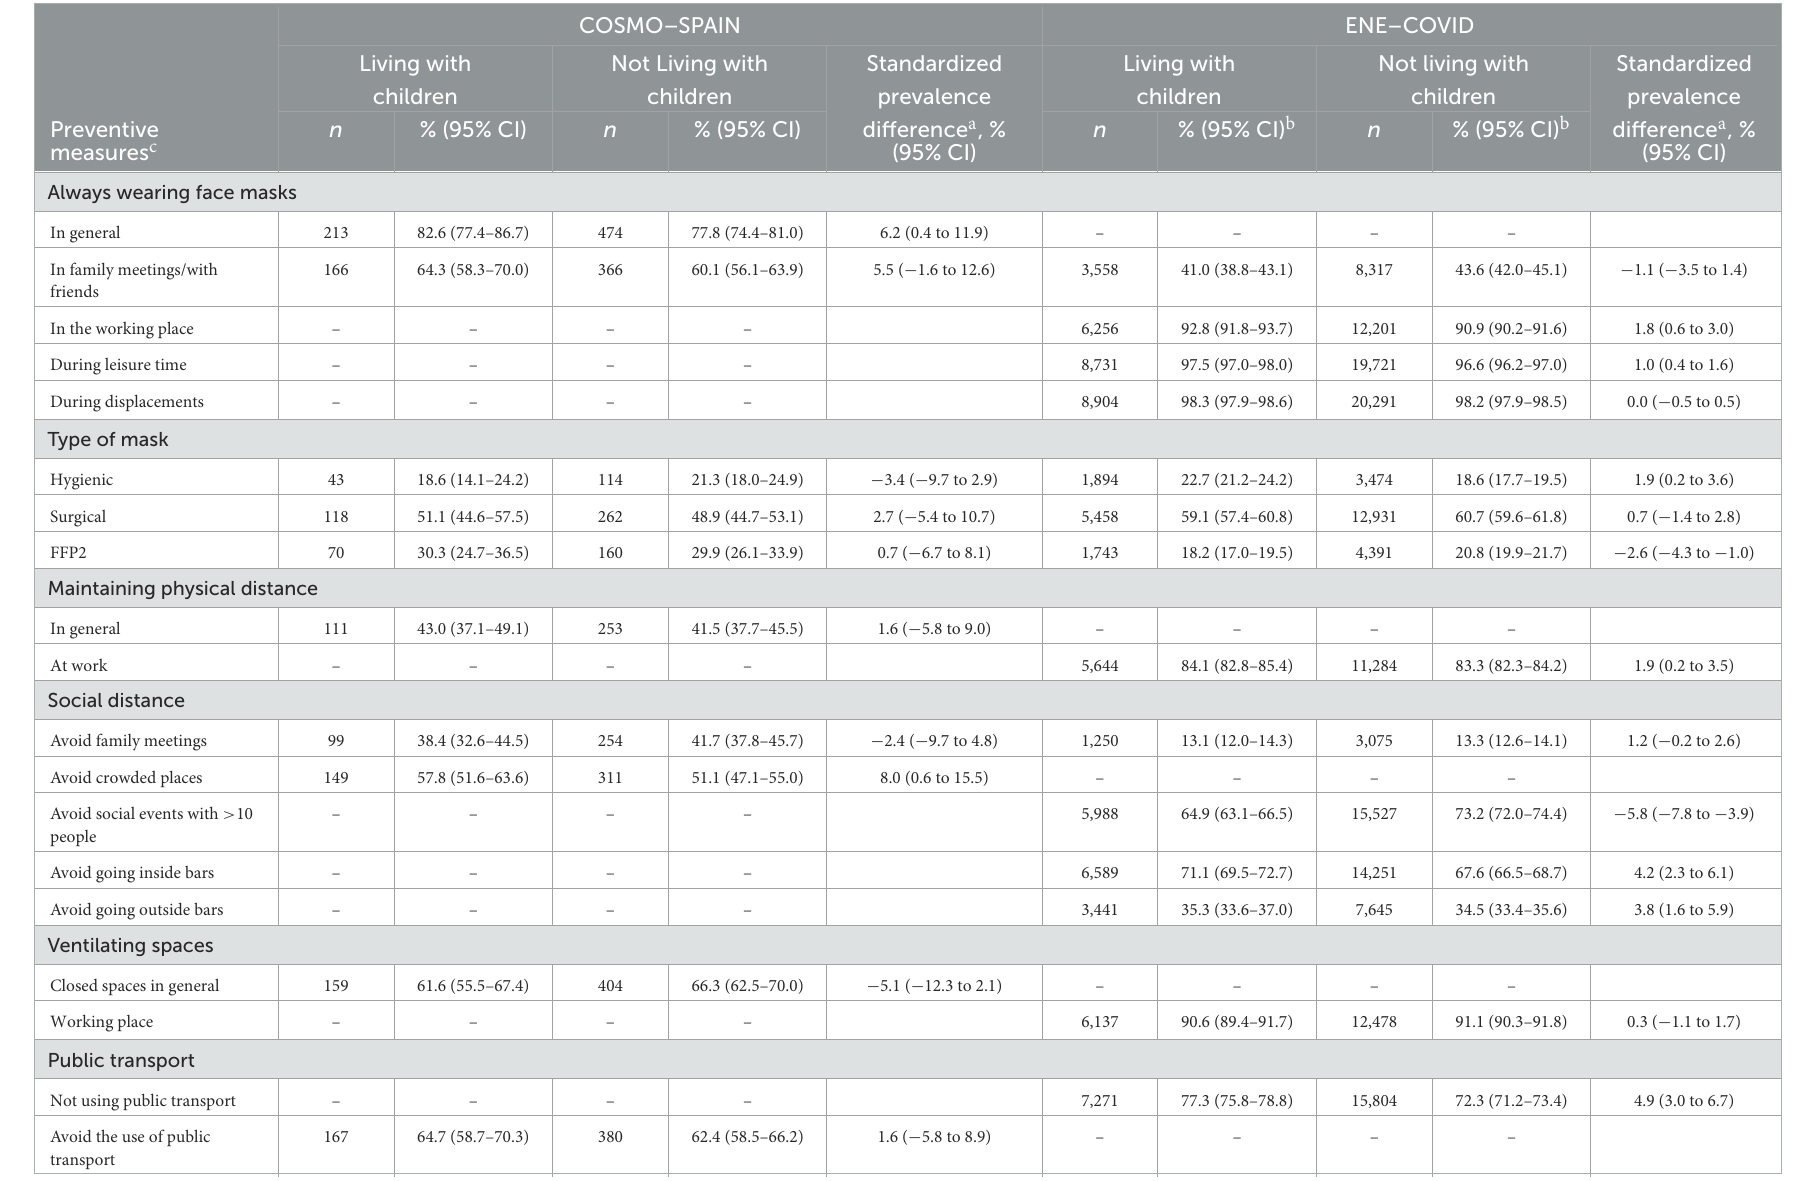
TABLE 3 Preventive practices of young and middle-aged COSMO-SPAIN and ENE-COVID participants, according to the presence of children in the household, November 2020. COSMO–SPAIN ENE–COVID Living with Not Living with Standardized Living with Not living with Standardized children children prevalence children children